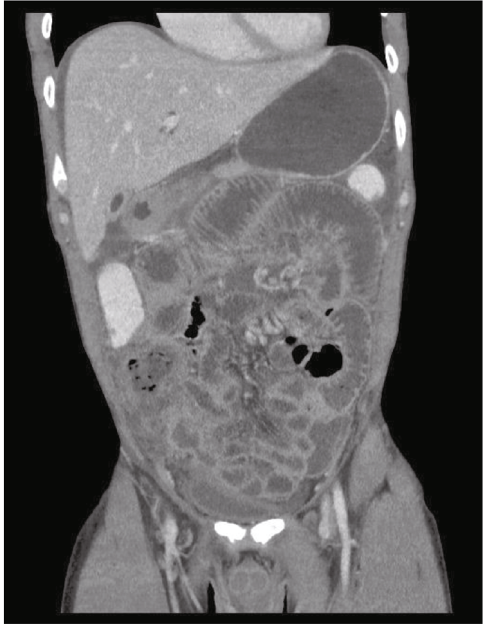
Figure 1: CT abdomen with evidence of ileus most localized in the area of the ileocecal valve with questionable characteristics. No evidence of intra-abdominal free air or peri/subhepatic